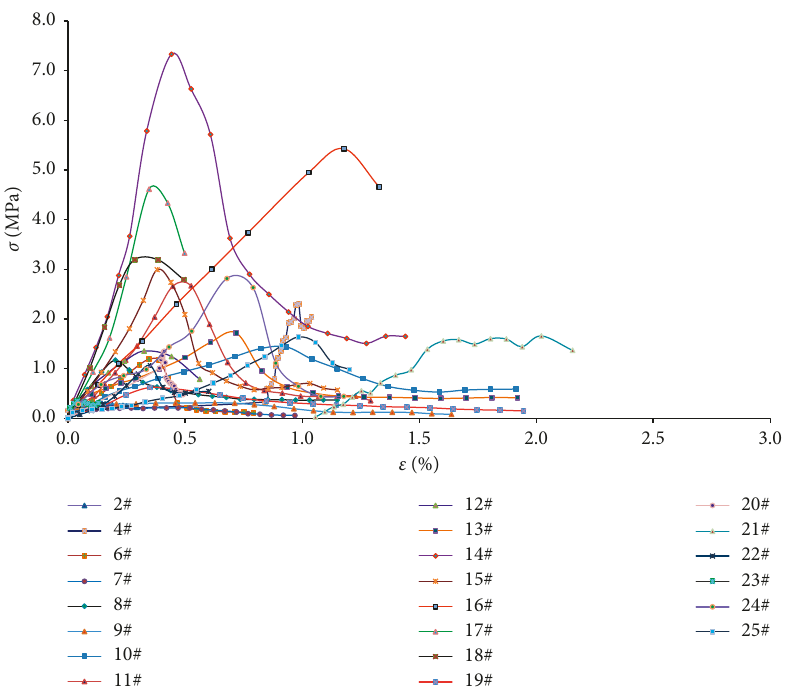
Figure 5: Stress-strain relationship curve of the cemented sand column.